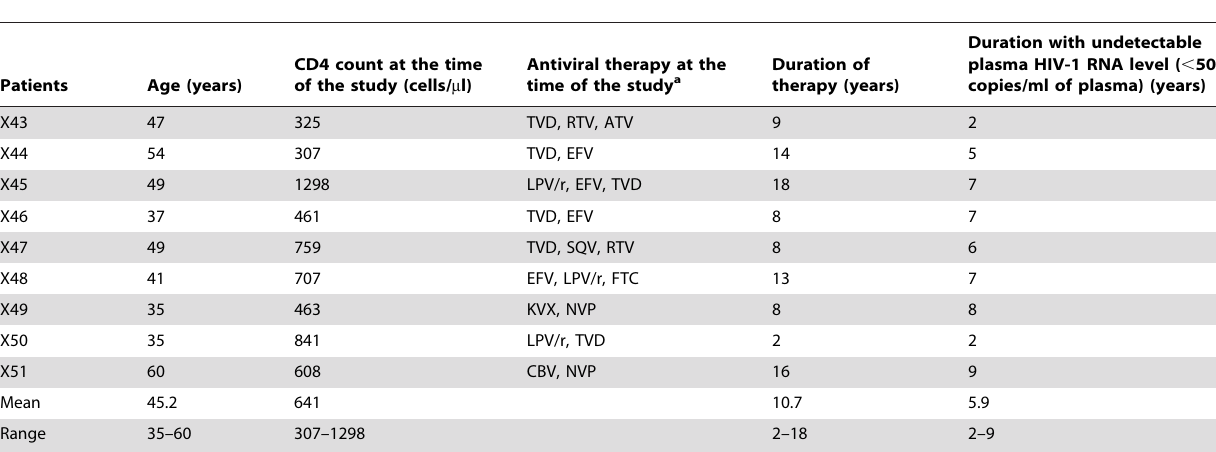
Table 3. Characteristics of HIV-1-infected individuals named X43 to X51.